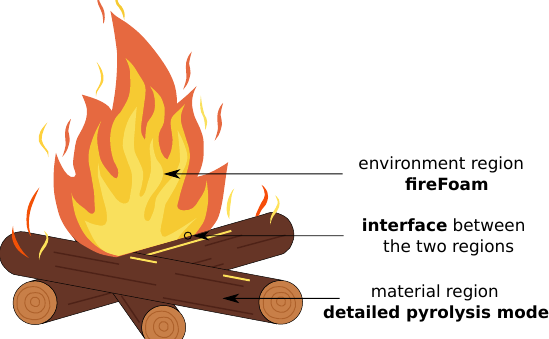
Figure 1. A generic combustion problem. Two different regions are present: the environment, where combustion happens, and the material, characterized by